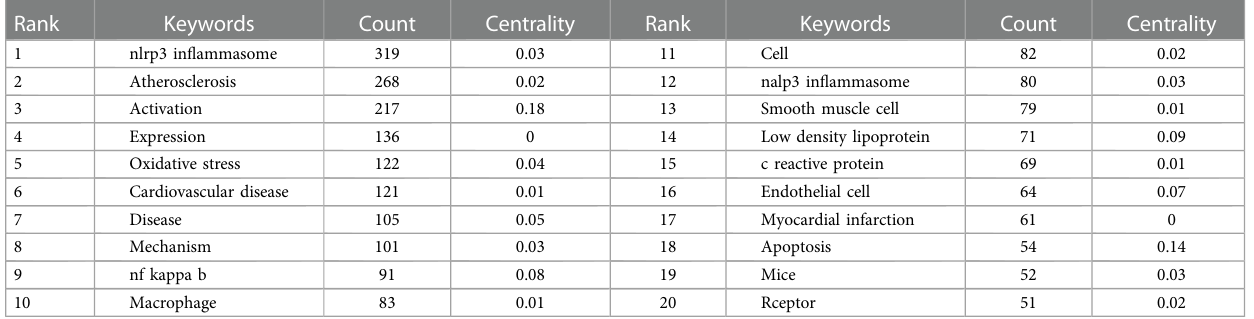
TABLE 5 Top 20 keywords related to “ in fl ammasome AND atherosclerosis ”